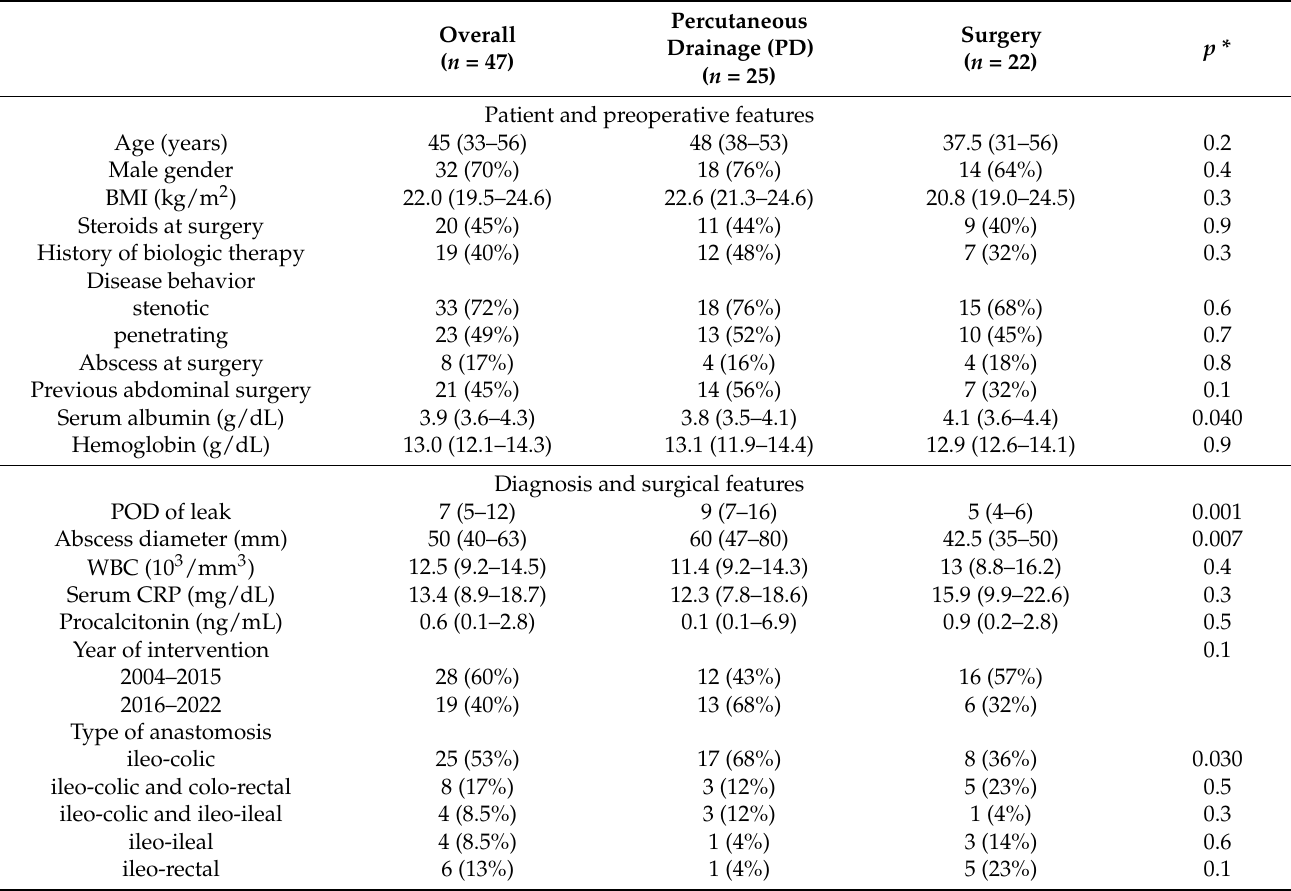
Table 1. Patients’ characteristics, surgery features and